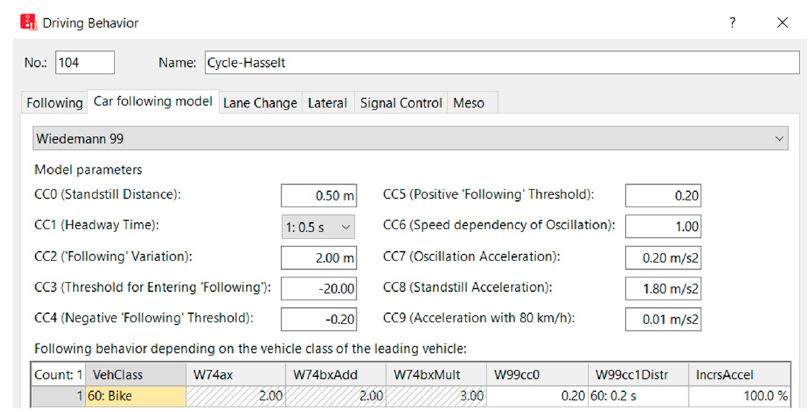
Figure 2. Adapted car following model for cyclists.